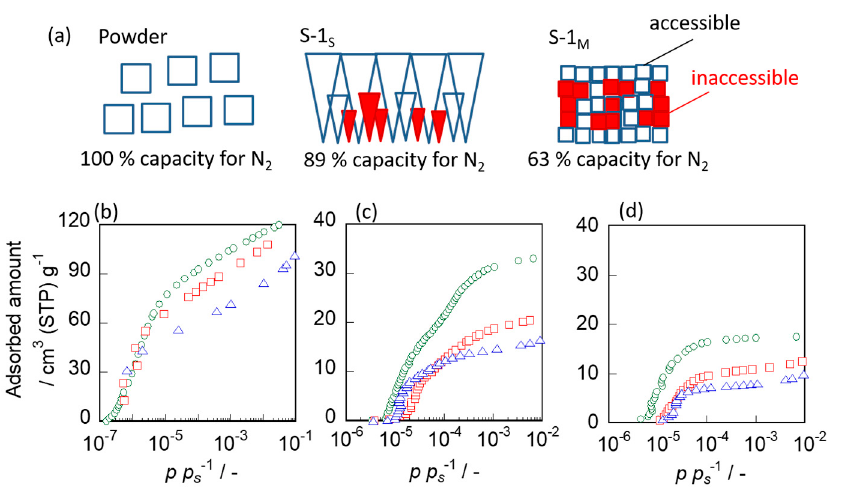
Figure 6. ( a ) Schematic diagram of accessible volumes in the powder and membrane. Adsorption isotherms of ( b ) N 2 , ( c ) n -hexane and ( d ) 2-methylpentane for ○ , silicalite-1 powder; □ , S-1 S ; ▵ , S-1 M .